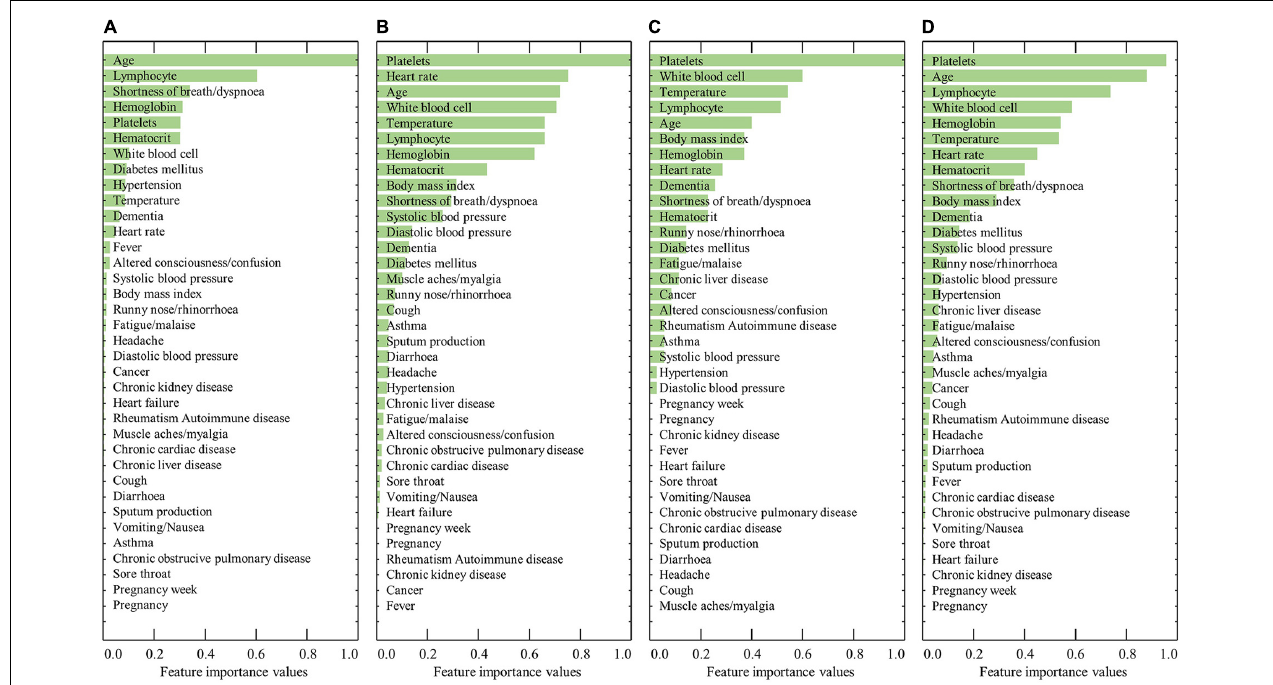
FIGURE 1 | Results of the ranked feature importance values for the male group using (A) RF, (B) XGBoost, (C) AdaBoost, and (D) average after normalization.